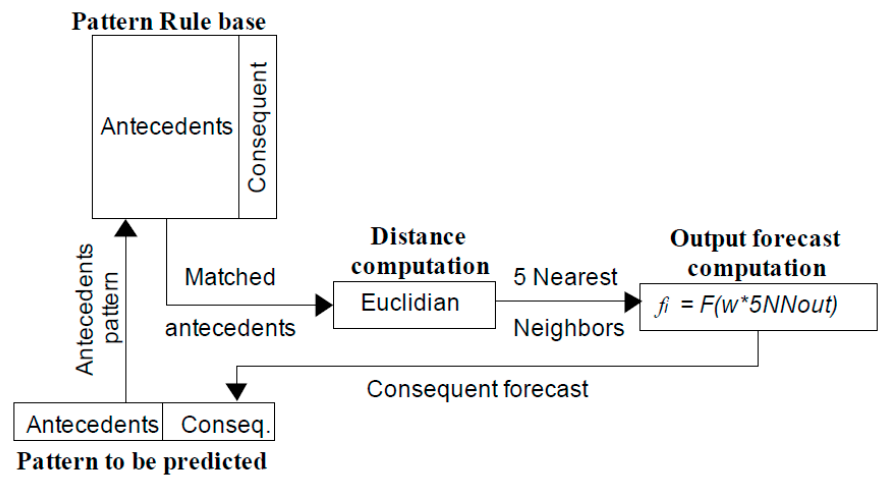
Figure 4. FIR prediction process diagram.